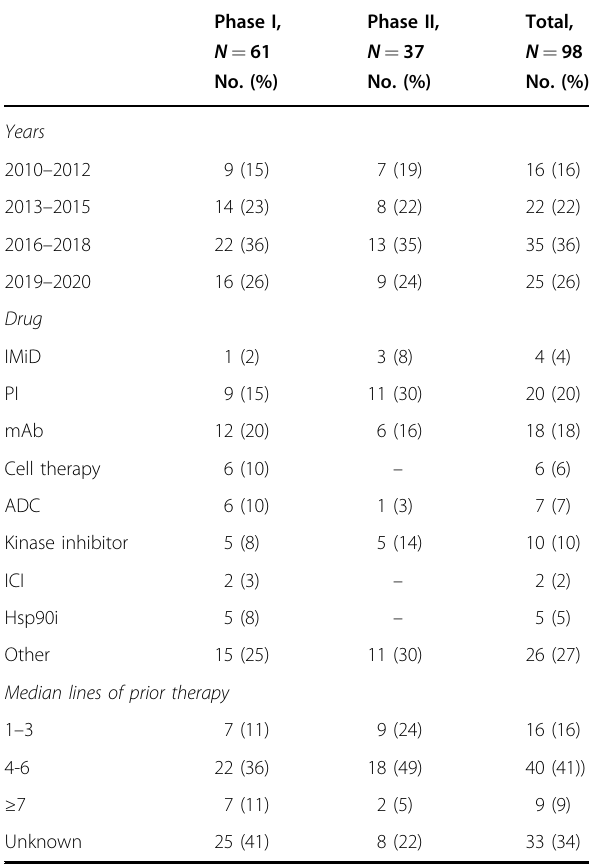
IMiD immunomodulatory imide drugs, PI proteasome inhibitors, mAb mono- clonal antibodies, ADC antibody – drug conjugate, ICI immune checkpoint inhibitor, Hsp90i heat-shock protein